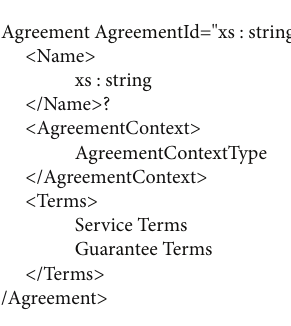
Figure 1: Policy assertions control WS-BPEL processes to satisfy quality objectives.